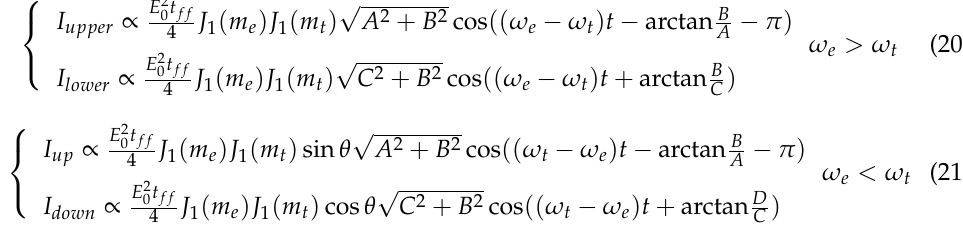
Figure 8. Slopes of ACFs versus different deviations of α 1 and α 3 . ( a ) The influence of α 1 deviation of − 20 ◦ , − 10 ◦ , 0 ◦ , 10 ◦ and 20 ◦ , respectively. ( b ) The influence of α and 20 ◦ ,